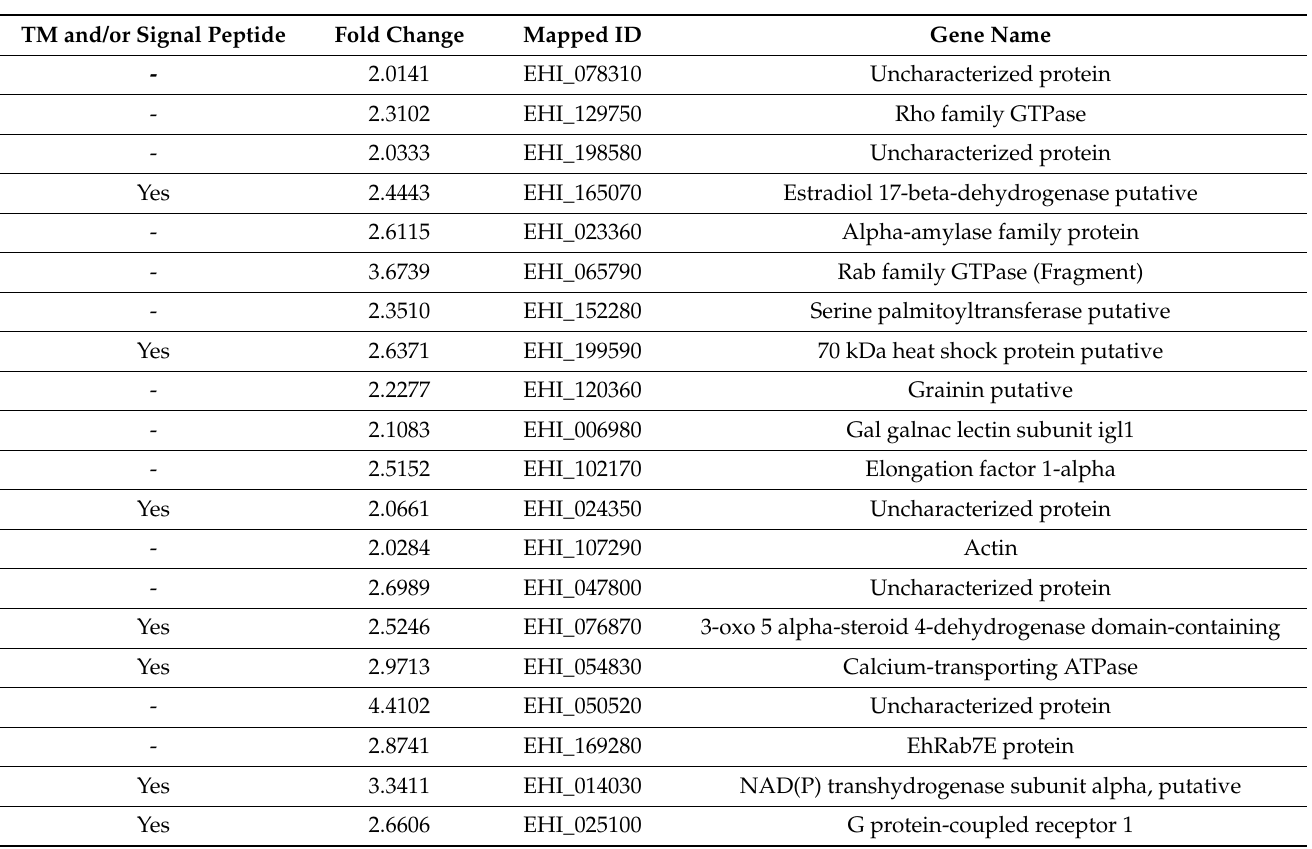
Table 2. Increased abundant membrane and cytosolic proteins in the membrane versus cytosolic fractions (q < 0.05). TM and/or Signal